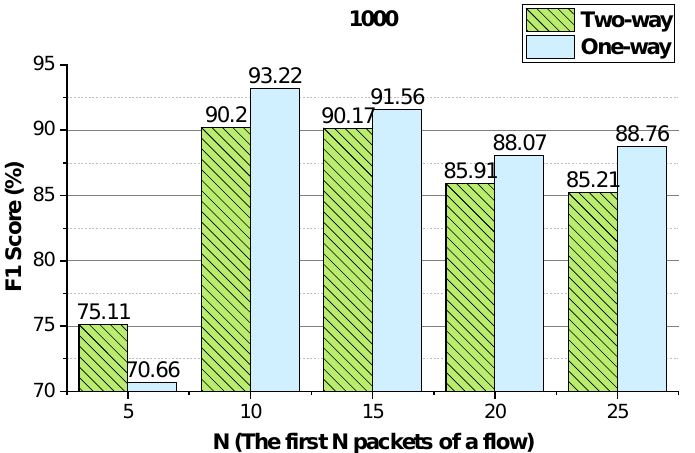
Figure 4. When the integer conversion value of the packet inter-arrival time is 1000, the Shadowsocks traffic detection performance of the method using the two-way and one-way packet inter-arrival time sequences of the flow, respectively.